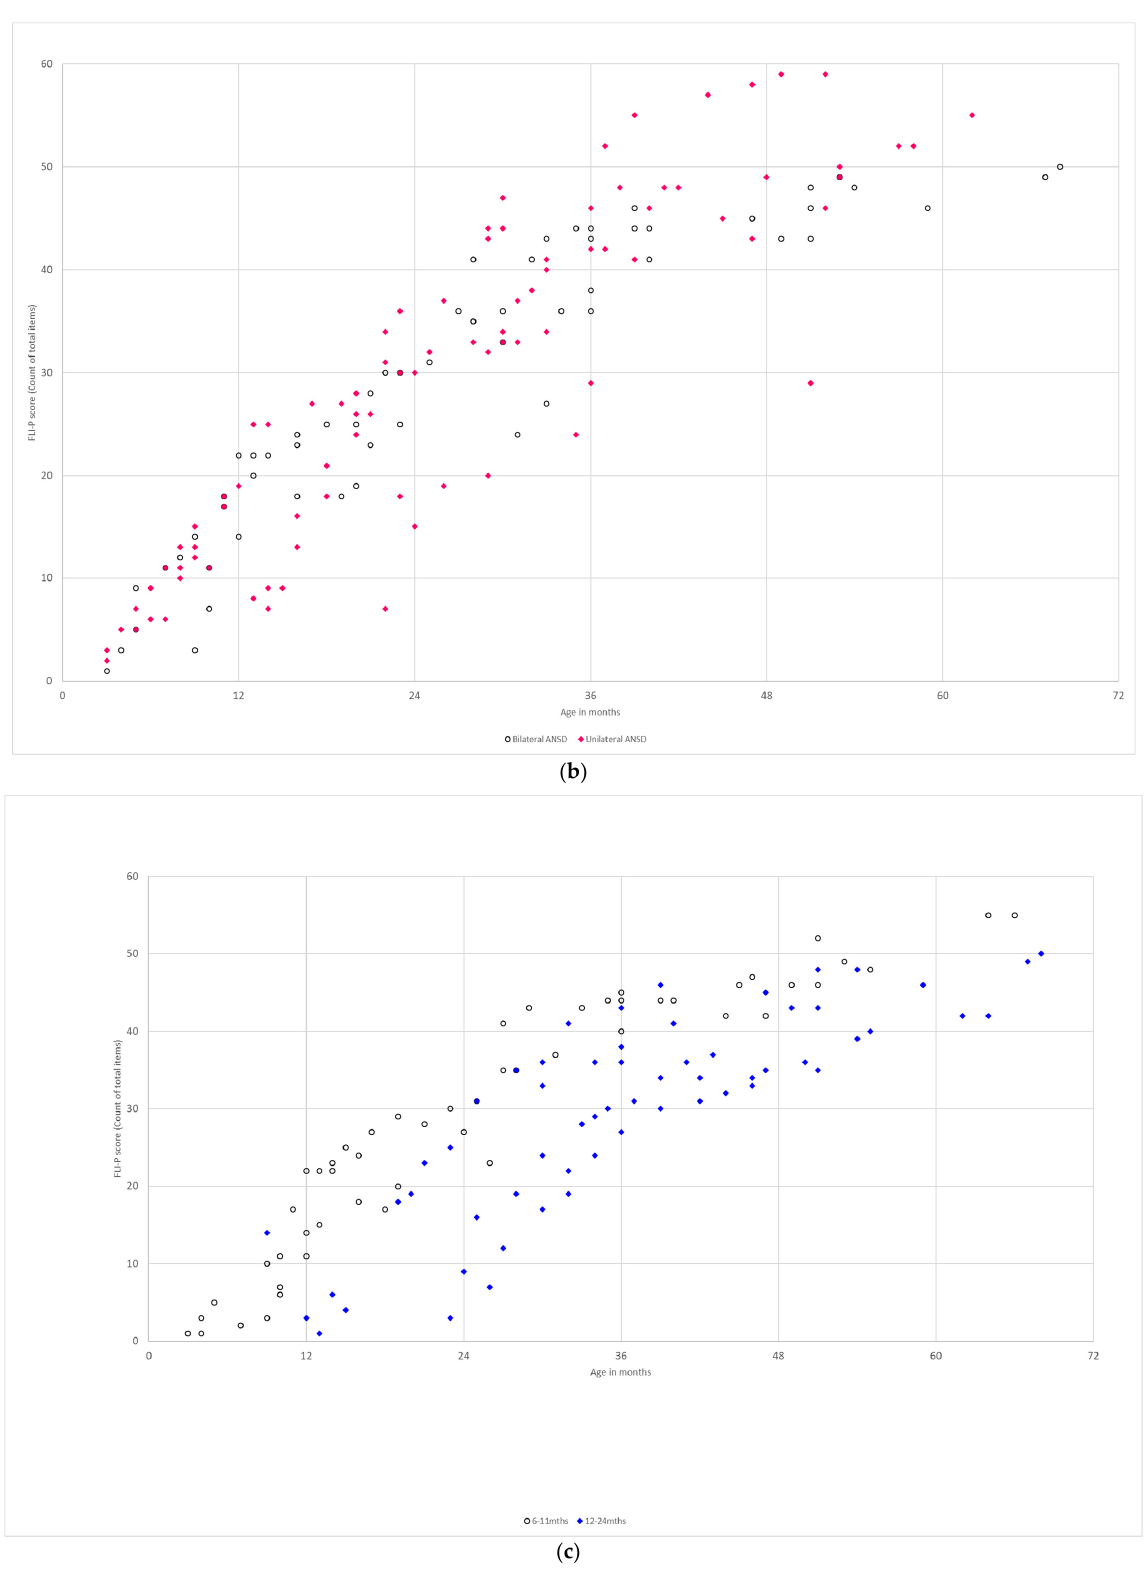
Figure 9. FLI-P scores ( a ) bilateral ANSD (no color) vs. unilateral ANSD (colored dots); ( b ) bilateral ANSD (no color) vs. unilateral ANSD (colored dots), no additional development needs; and ( c ) bi- lateral ANSD with a CI between 6 and 11 months ( n = 5) (no color) and 12 and 23 months ( n = 6) (colored dots). The FLI-P scores for the children with hearing loss who were referred for diagnostic testing of hearing following newborn screening ( n = 427, 2442 FLI-P scores) were com- pared to the FLI-P scores of children who passed newborn screening and were later diag- nosed with a hearing loss ( n = 54, 168 FLI-P scores). Information was not recorded in the database for 43 children (183 scores), and 19 children did not have their hearing screened at birth (76 FLI-P scores). For comparative purposes, Figure 10 displays the results of chil- dren with a bilateral moderate hearing loss or greater, referred through newborn hearing screening and had their first device fitted < 6 months of age, compared with children who passed newborn hearing screening and had their first devices fitted > 12mths of age. Greater variability in FLI-P scores is evident across all age ranges for children who passed newborn hearing screening. Given the amount of time children who are later diagnosed may have had without aiding and necessary access to sound, lower listening scores and higher levels of variability in scores would be expected.